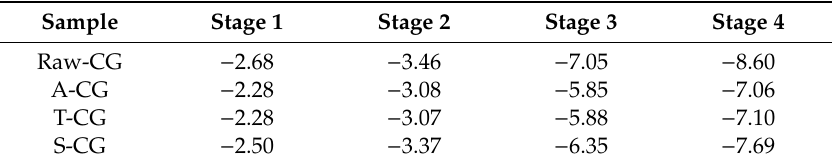
Table 3. Maximum vertical displacement /